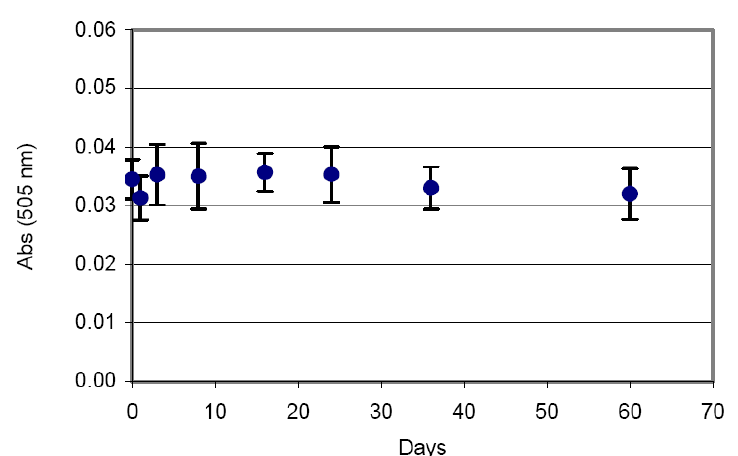
Figure 11. The long-term stability of the optical biosensor based on immobilized laccase in chitosan film.